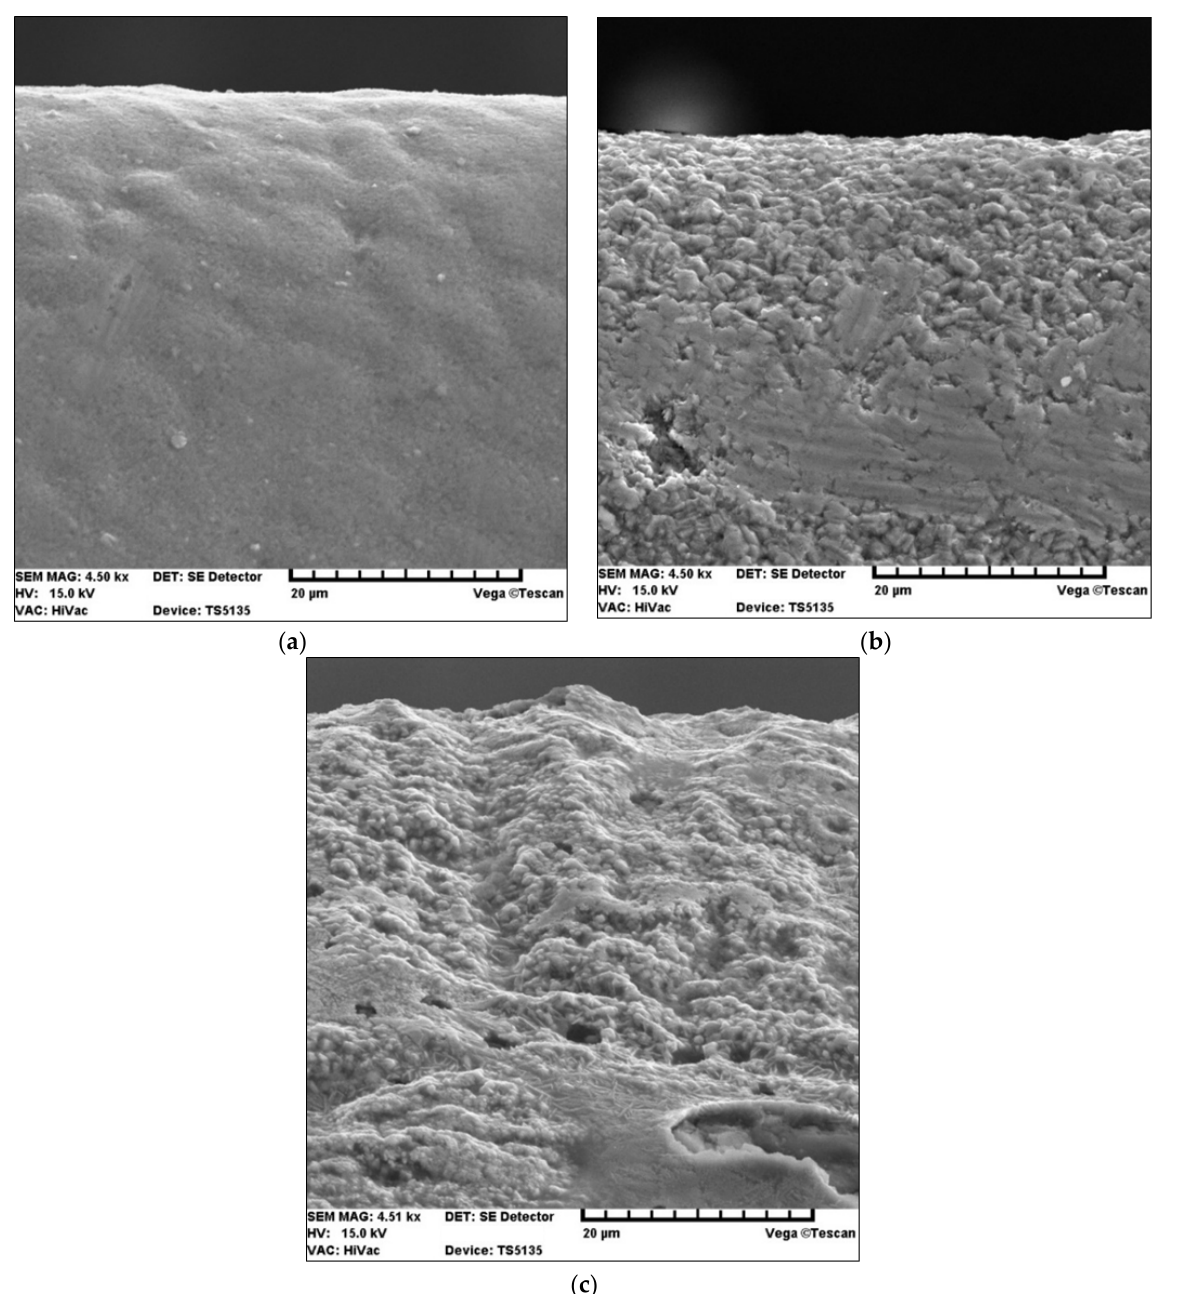
Figure 15. Secondary electron images (SEIs) of SM25 cutting blades coated with TiCN + TiN, after heating with ( a ) 40%, ( b ) 50%, and ( c ) 60% laser power. The coating adhesion to the substrate, as well as the cutting tool life, can be affected by changes in the coating material chemical composition induced by laser heating. To give